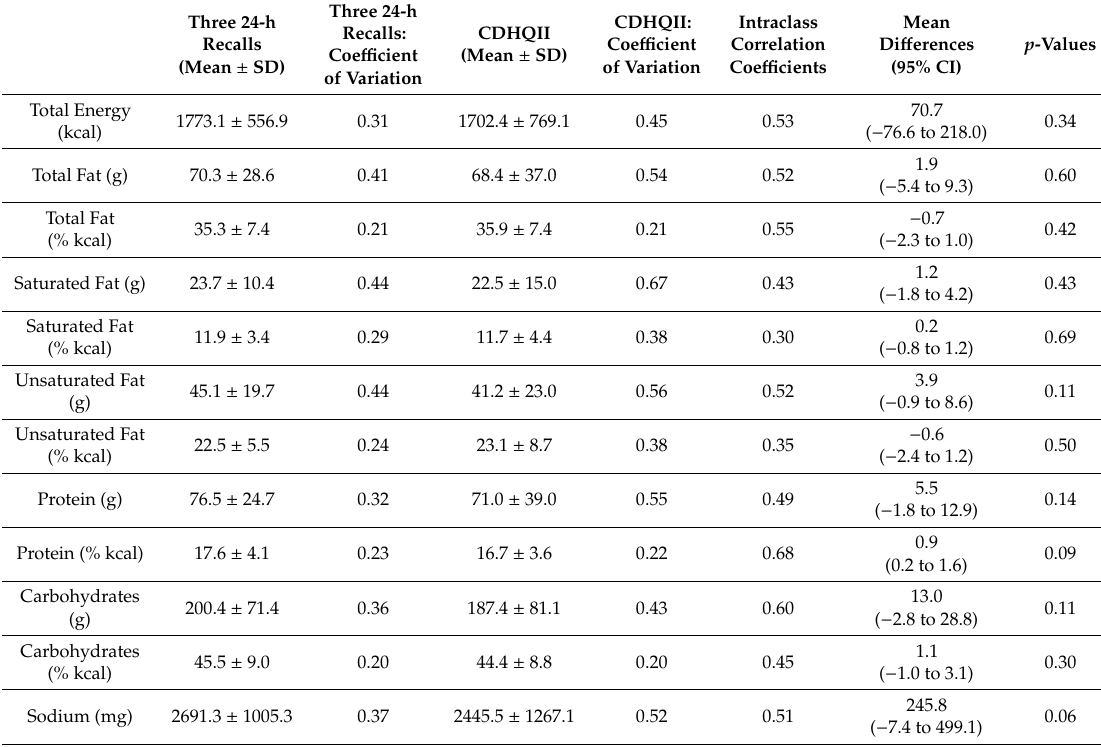
Table 1. Comparison of three 24-h recalls and CDHQII results at